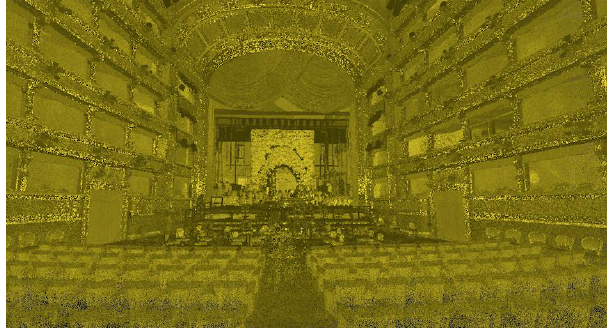
Figure 9. Horizontal projection of the Dome (from the original Basile’s drawings) with station points (PS1, PS2) and measured points